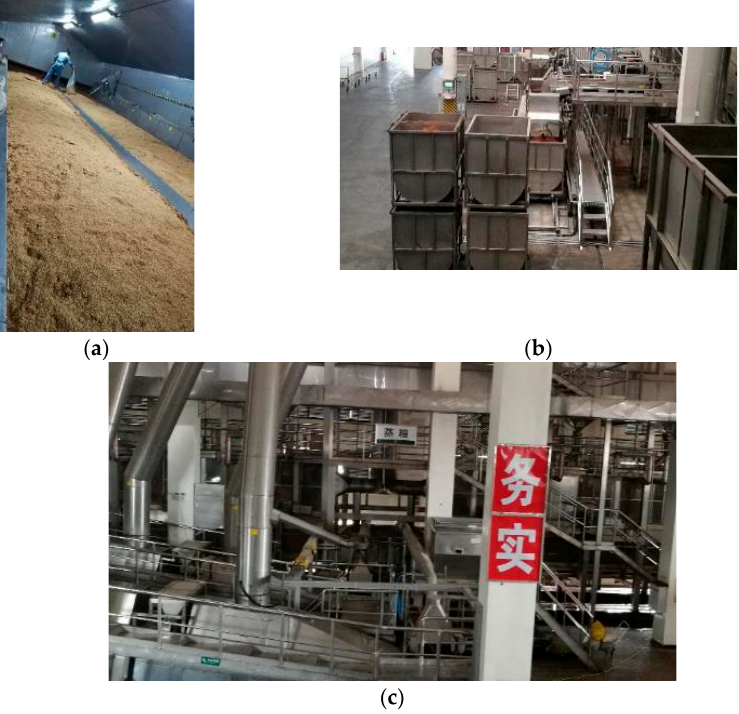
Figure 10. Automatic production line for Xiaoqu mild flavor Baijiu. ( a ) Saccharification workshop; ( b ) fermentation tanks; ( c ) production workshop (the figures are kindly provided by Fenglin dis- tillery of Jingpai Co., Ltd., Huangshi, China).